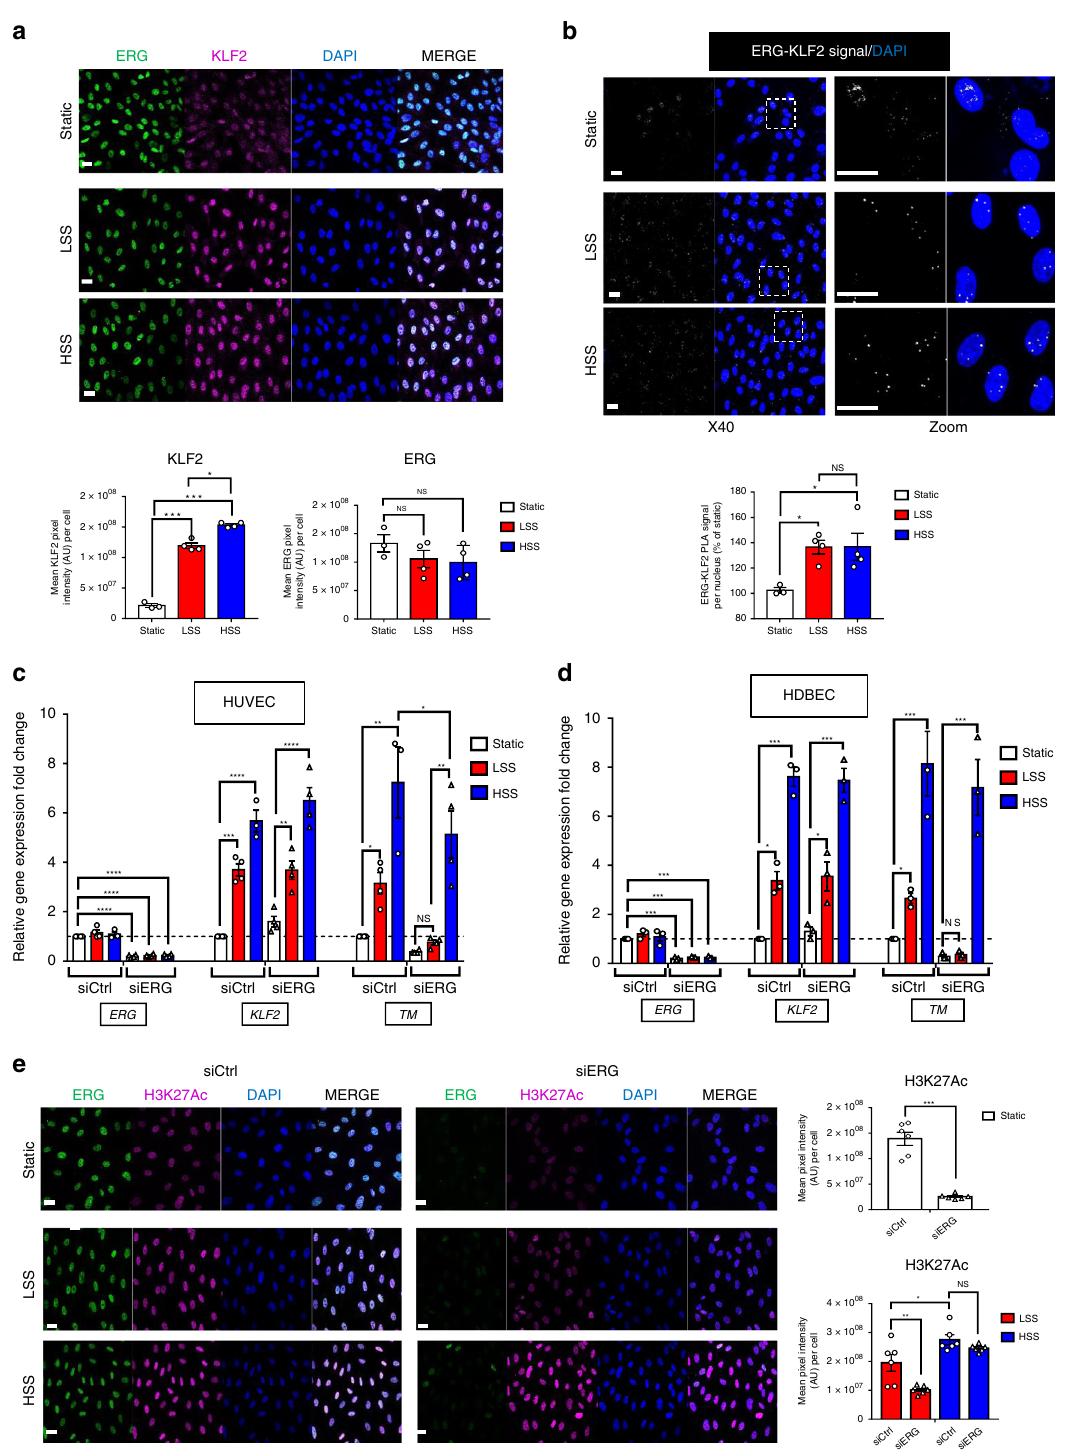
Methods 0.5 mg daily). All experiments were conducted using littermate controls; mice were Mice and breeding . All animal experiments were conducted according to and in monitored, and tissues were harvested 25, 30 or 45 days post-tamoxifen injection. compliance with the guidelines from Directive 2010/63/EU of the European Par- liament for animal testing and research, with ethical approval from Imperial College London under UK Home Of fi ce Licence number PPL PEDBB/1586 and in Cell culture and fl ow experiments . Pooled human umbilical vein endothelial cells compliance with the UK Animals (Scienti fi c Procedures) Act of 1986. The indu- (HUVEC) were purchased from Lonza (C2519A) (Wokingham, United Kingdom) cible endothelial-speci fi c ERG knockout mouse model ( Erg iEC-KO ) was generated and cultured in Endothelial Cell Growth Medium-2 media (EGM-2) (Lonza) or by breeding Erg fl / fl mice 30,33 with Cdh5 (PAC)- CreERT2 mice 53 ; 10 – 12 weeks old isolated from umbilical cords 33,36 and cultured in M199 media. Human aortic male and female mice were used for this study. Endothelial deletion of ERG was endothelial cells (HAEC) (single donor, Promocell, C-12271) were cultured in induced in adult mice, between 6 – 8 weeks, by tamoxifen injection ( fi ve injections of EGM-2 media (Lonza). Human dermal microvascular endothelial cells (HDMEC) NATURE COMMUNICATIONS| (2019) 10:5014